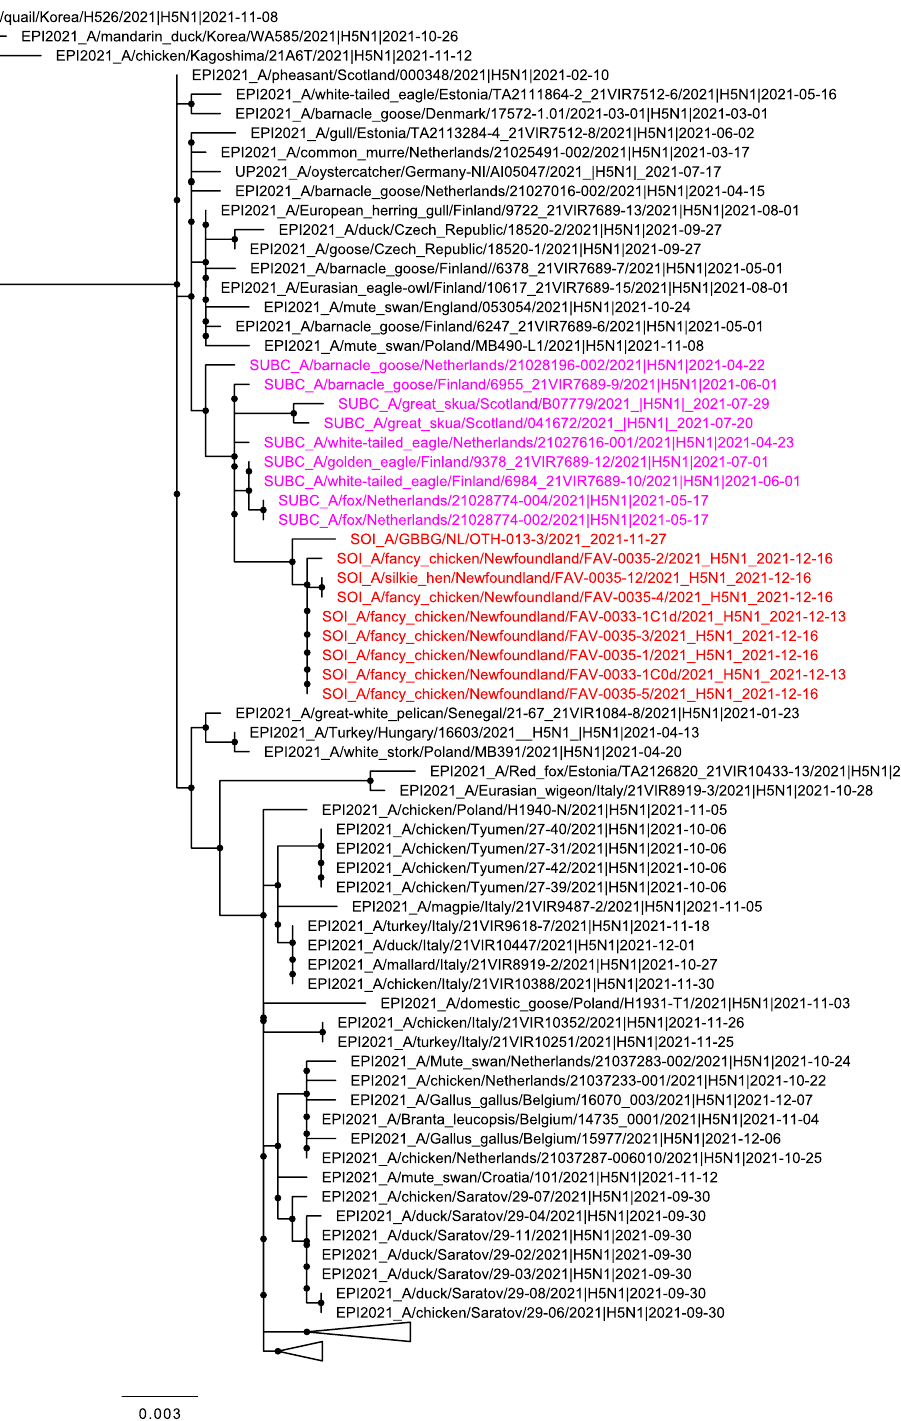
Figure 1. Maximum likelihood phylogenetic tree of the H5 HA gene. Relationships among the European 2021 H5 2.3.4.4b HPAI strains (magenta) and the Newfoundland wild bird and outbreak strains (red) are shown. The tree is rooted by the outgroup and nodes placed in descending order. Clades are collapsed for